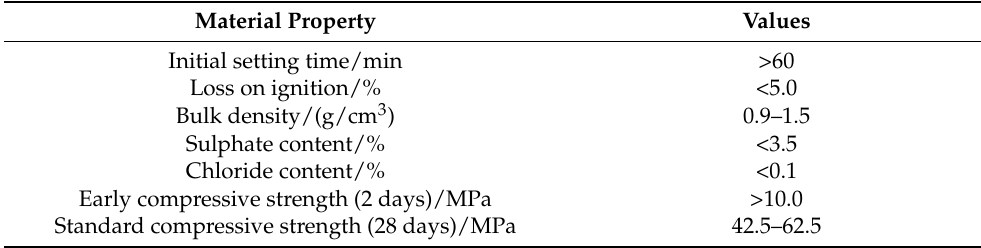
Table 1. Material characteristics of OPC used in the experiments.